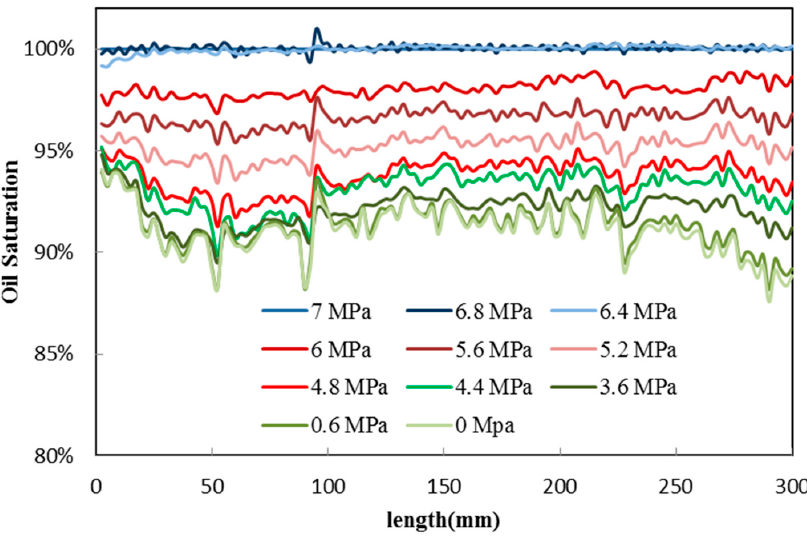
Figure 2 . Oil saturation distribution curves in Experiment 1 (300 mm is the outlet of the core).